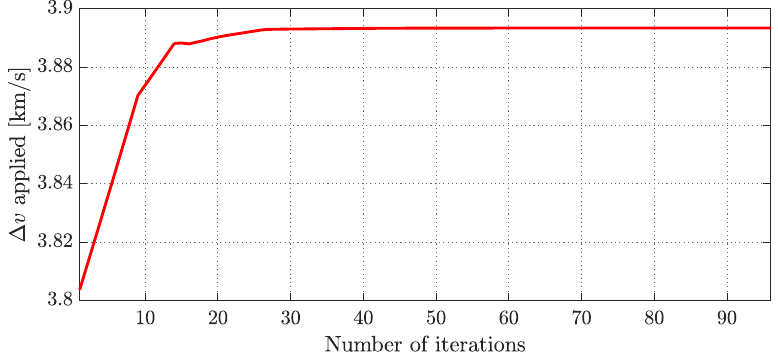
Figure 10. Evolution of the magnitude of the ∆ v impulse, in km/s, applied on the vehicle at the beginning of the propagation as the iterative process of correction